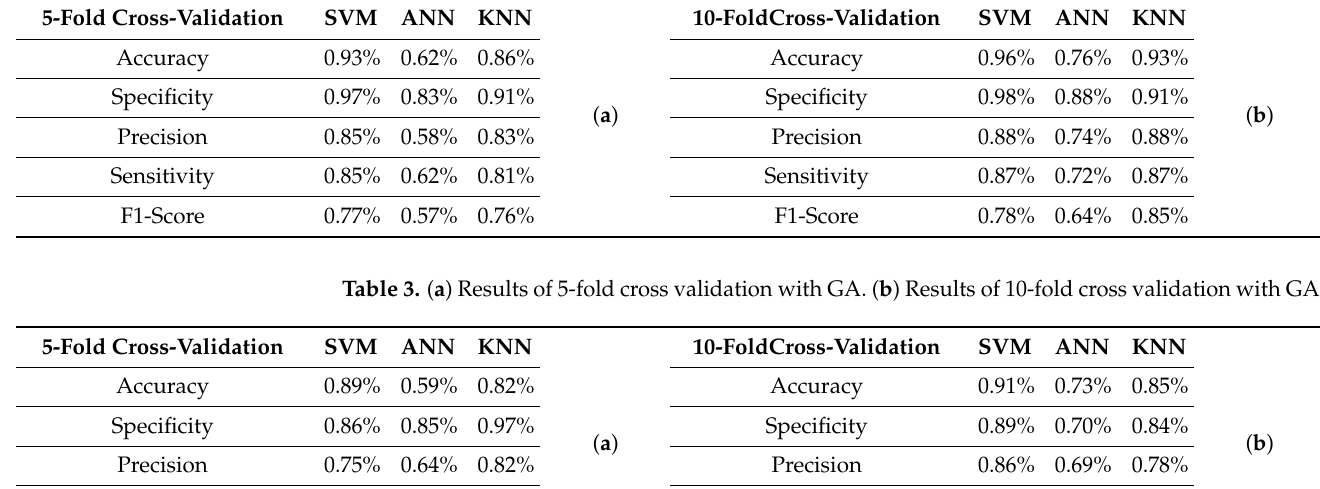
Figure 9. Loss curves of bees and genetic algorithm. Table 2. ( a ) Results of 5-fold cross validation with BA. ( b ) Results of 10-fold cross validation with BA.